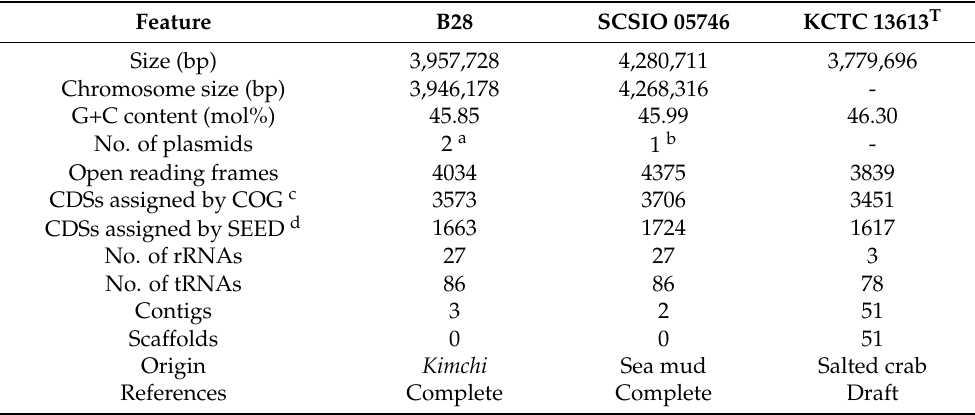
Table 1. Genome features of Bacillus siamensis